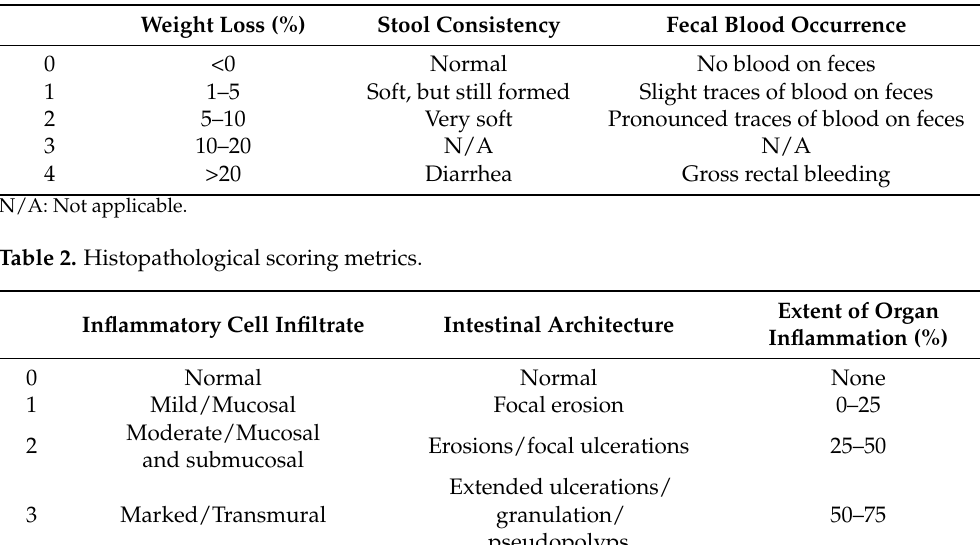
Table 1. Disease activity index (DAI) scoring metrics.